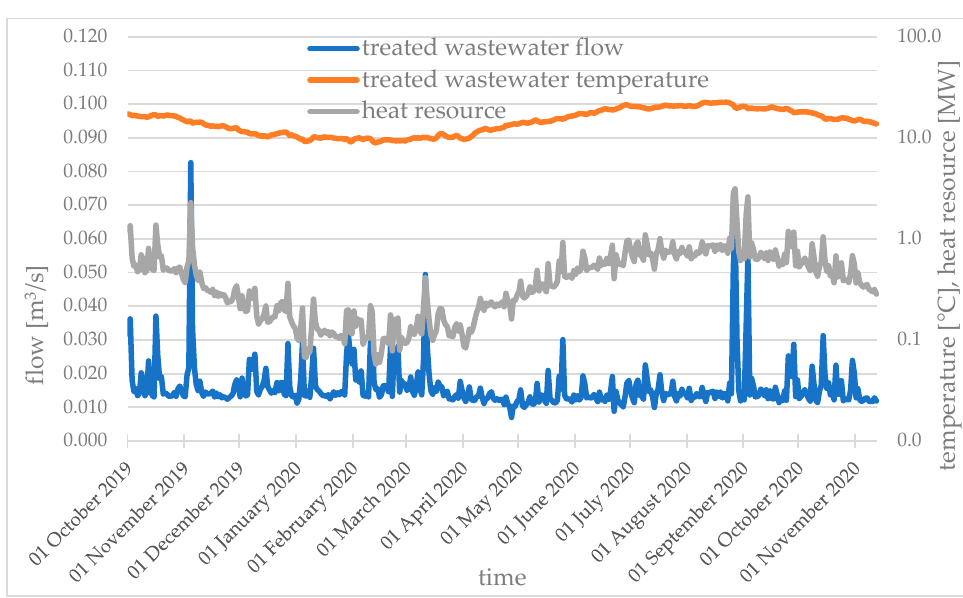
Figure 6. Potential for heat recovery from treated wastewater.